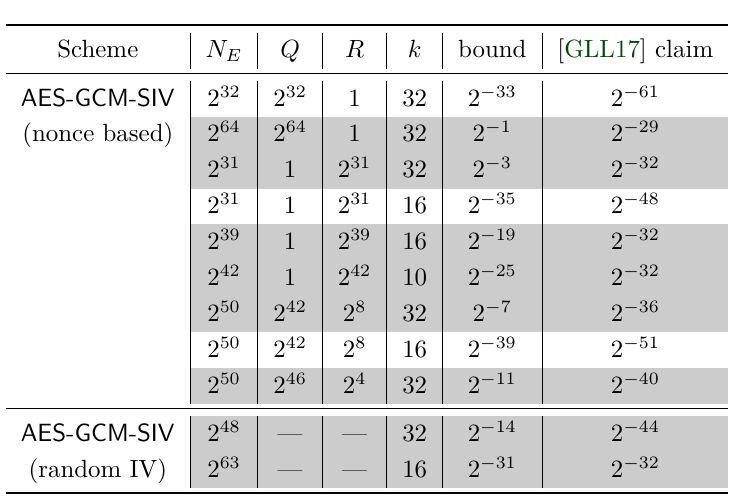
Table 1: Security bound for AES - GCM - SIV revised according to the leading term of Theorem 2 and Corollary 1 compared with claims in [GLL17, Fig. 4]. We highlight in gray parameters for which the security bound is above 2 − 32 and should be considered insecure according to NIST recommendations for GCM . For the nonce-based version, the total number of encryptions N E is set to QR